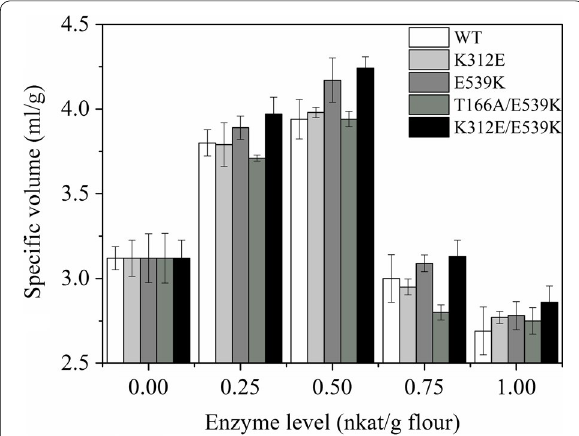
Fig. 3 Effect of Ts POx wild-type and the four mutants (K312E, E539K, T166A/E539K, and K312E/E539K) and its mutants on the volume of bread loaf. The number of samples was three for each